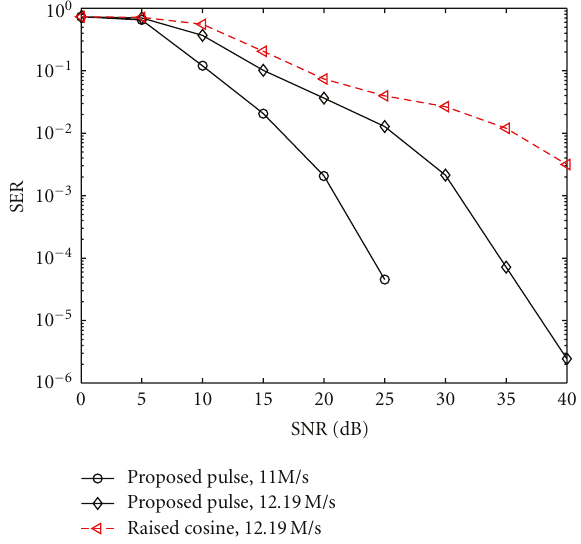
Figure 7: SER performance for di ff erent pulse-shapes and di ff erent symbol rates, with CFOs randomly chosen within the range [0,0 . 001 /T s